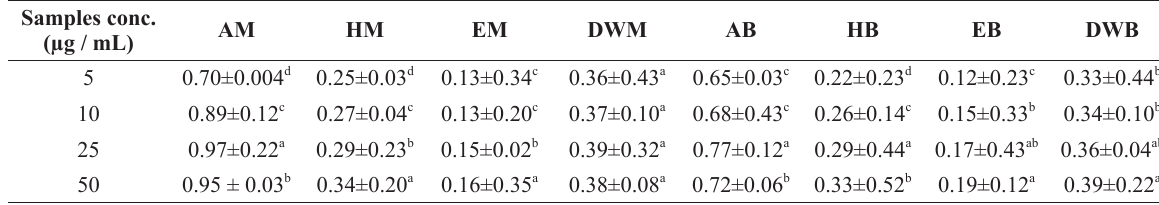
Reduction power of betel leaf